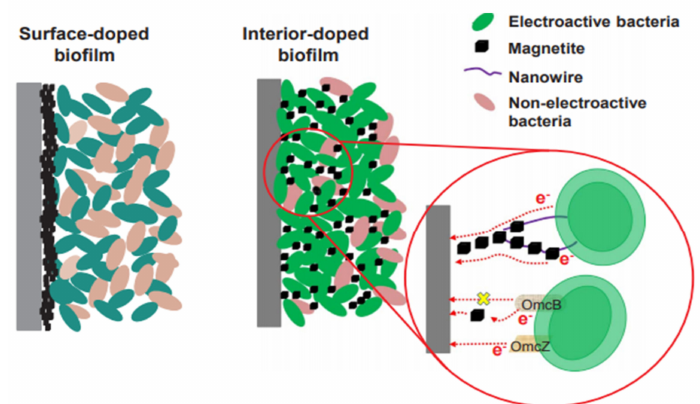
Figure 11. Rough sketch of the study, biofilm doped on the surface (left) and biofilm doped inside (right) [32]. No changes were made to the original